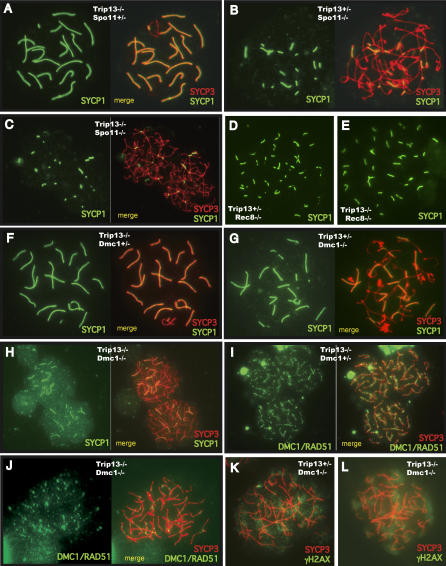
Immunocytological Analysis of Trip13 Compound MutantsSurface-spread chromosomes were immunolabeled with the indicated antibodies and fluorophores. Genotypes are indicated, as are those panels in which dual staining patterns are merged. Note that (H) and (I) are at lower magnification to show multiple nuclei.